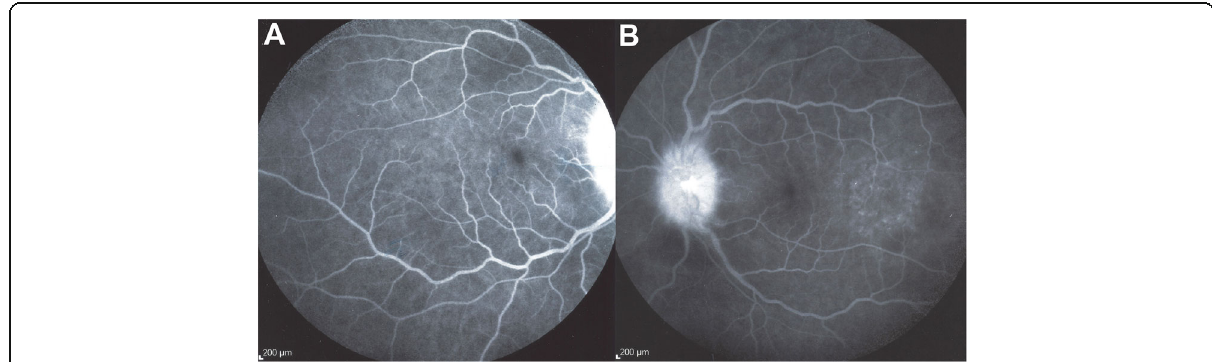
Fig. 2 FA: exsudative retinal detachements around optic disc ( a ) and temporal to the fovea OS ( b